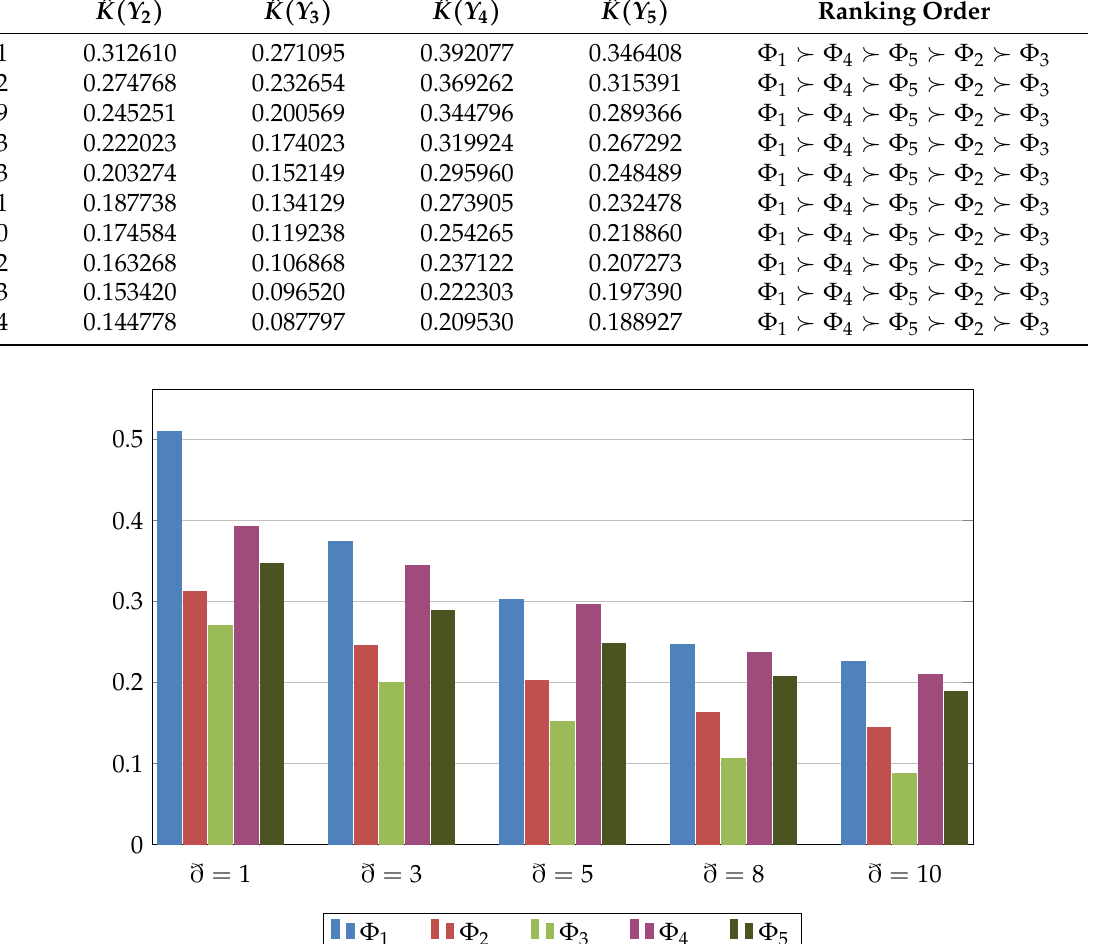
Figure 2. Score values belonging to the alternatives for various values ð by IVIFAAWG